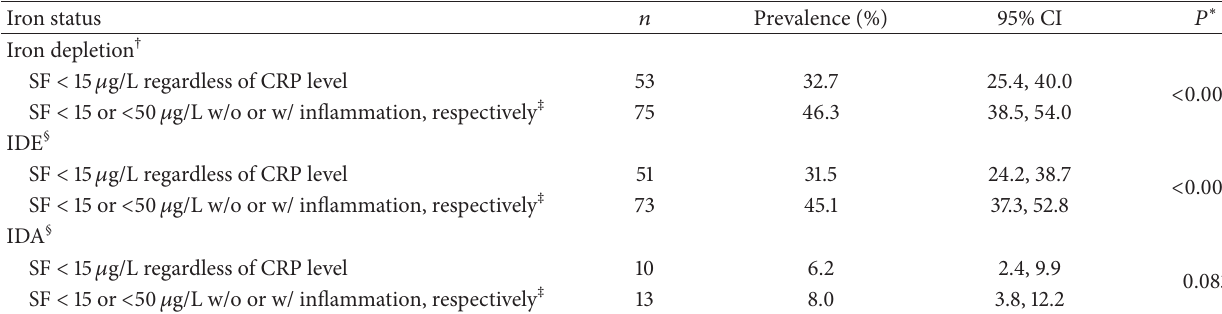
Table 4: Prevalence of iron depletion, IDE, and IDA in preschool Inuit children while disregarding or accounting for the influence of inflammation on SF cutoffs.